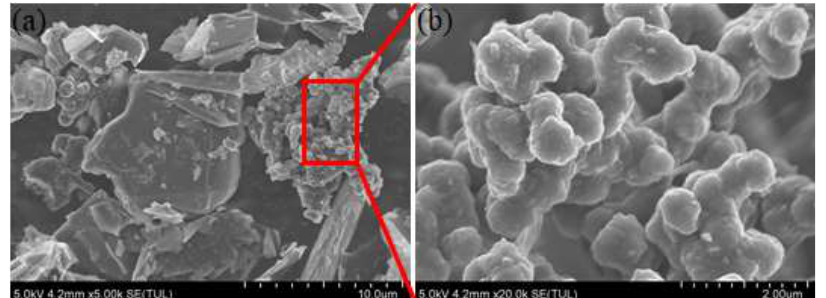
Figure 1. The topography of the mixture fillers ( a ) and the magnification picture of the red triangle box region ( b ).